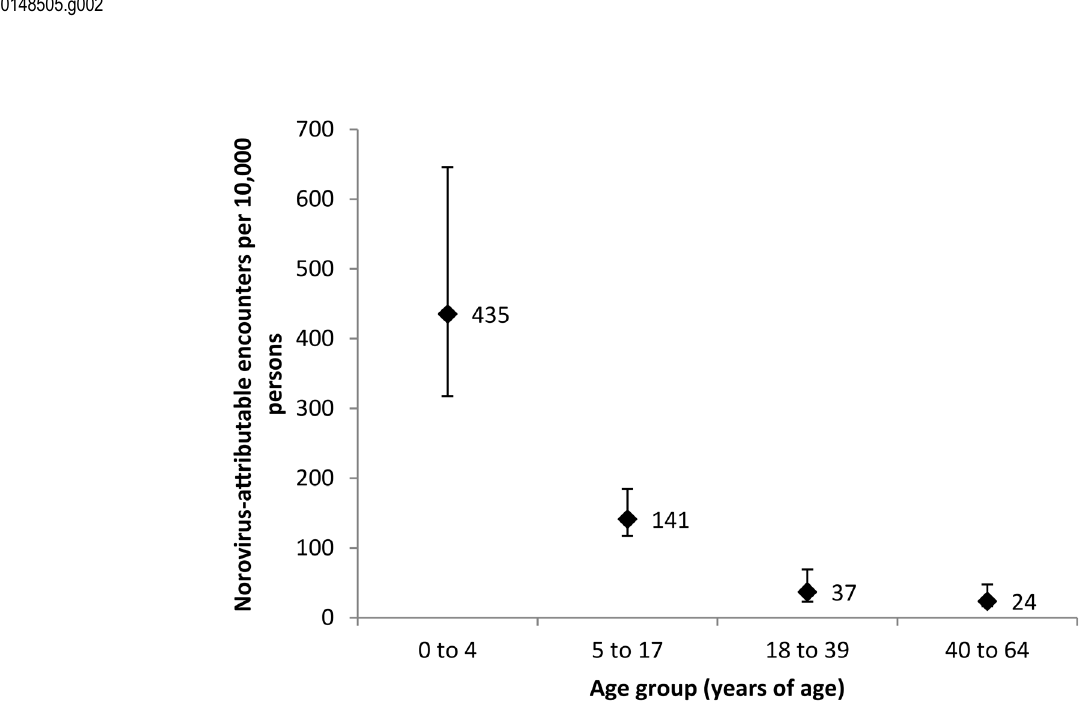
PLOS ONE | DOI:10.1371/journal.pone.0148505 April 26,